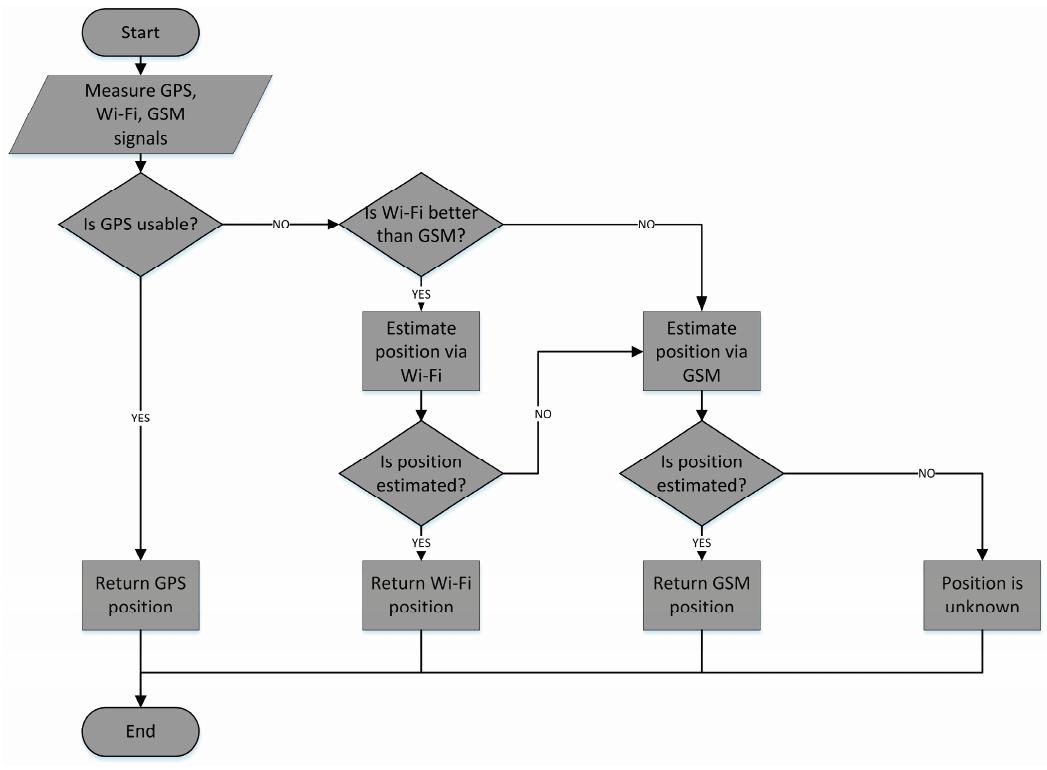
Figure 4. Flowchart of modular localization